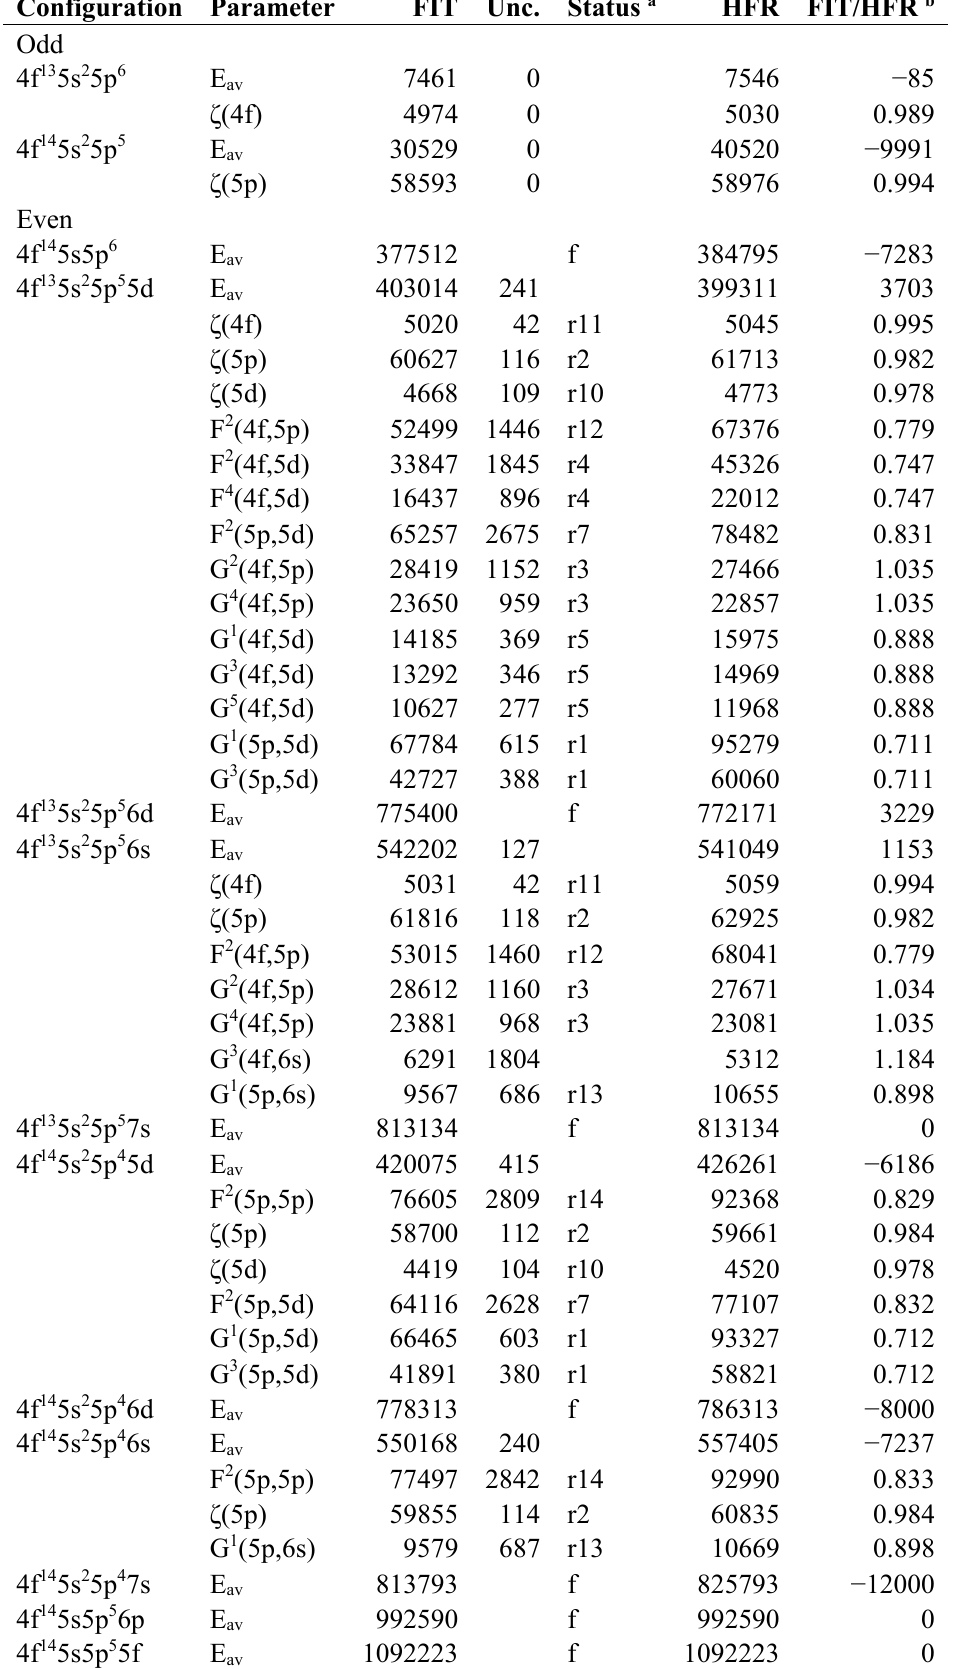
Table 3. Fitted (FIT) energy parameters (in cm − 1 ) of W VIII with uncertainties of their definition (Unc.) in comparison with the HFR